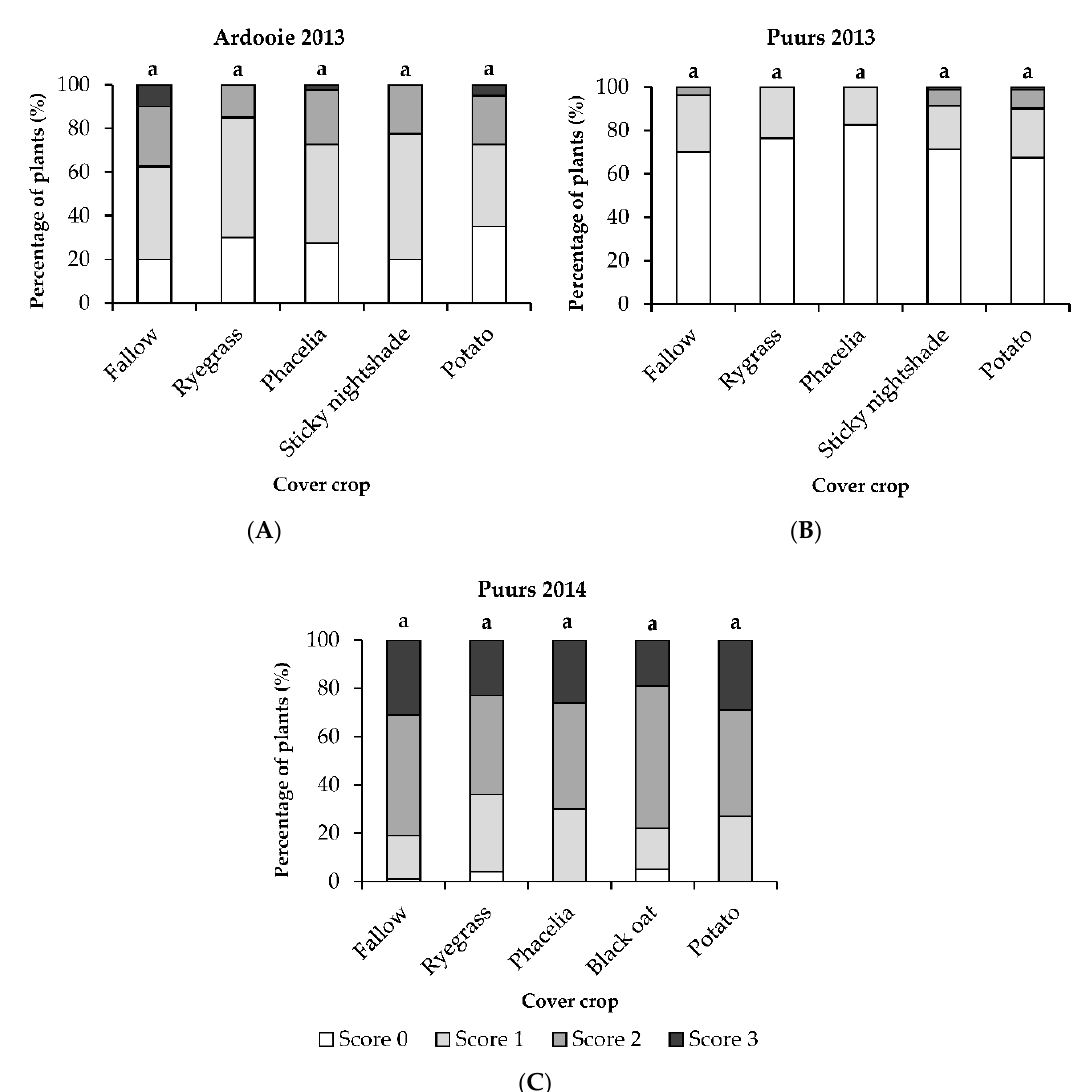
Figure 2. Verticillium wilt of cauliflower in grower’s fields located in Ardooie and Puurs during the growing seasons of 2013 and 2014 in five cover crop systems. ( A ) Vascular discoloration of the cauliflower stems in the field at Ardooie in 2013; ( B ) Vascular discoloration of the cauliflower stems in the field at Puurs in 2013; ( C ) Vascular discoloration of the cauliflower stems in the field at Puurs in 2014. Data are shown as the percentage of plants ( n = 20) with a specific score for vascular discoloration at harvest of the cauliflower curds: 0 = no vascular discoloration; 1 = vascular discoloration of <50% of stem length; 2 = vascular discoloration of 50–75% of stem length; and 3 = vascular discoloration of 76–100% of stem length. Bars indicated with the same letter are not significantly different according to a Mann–Whitney U-test ( p < 0.05).